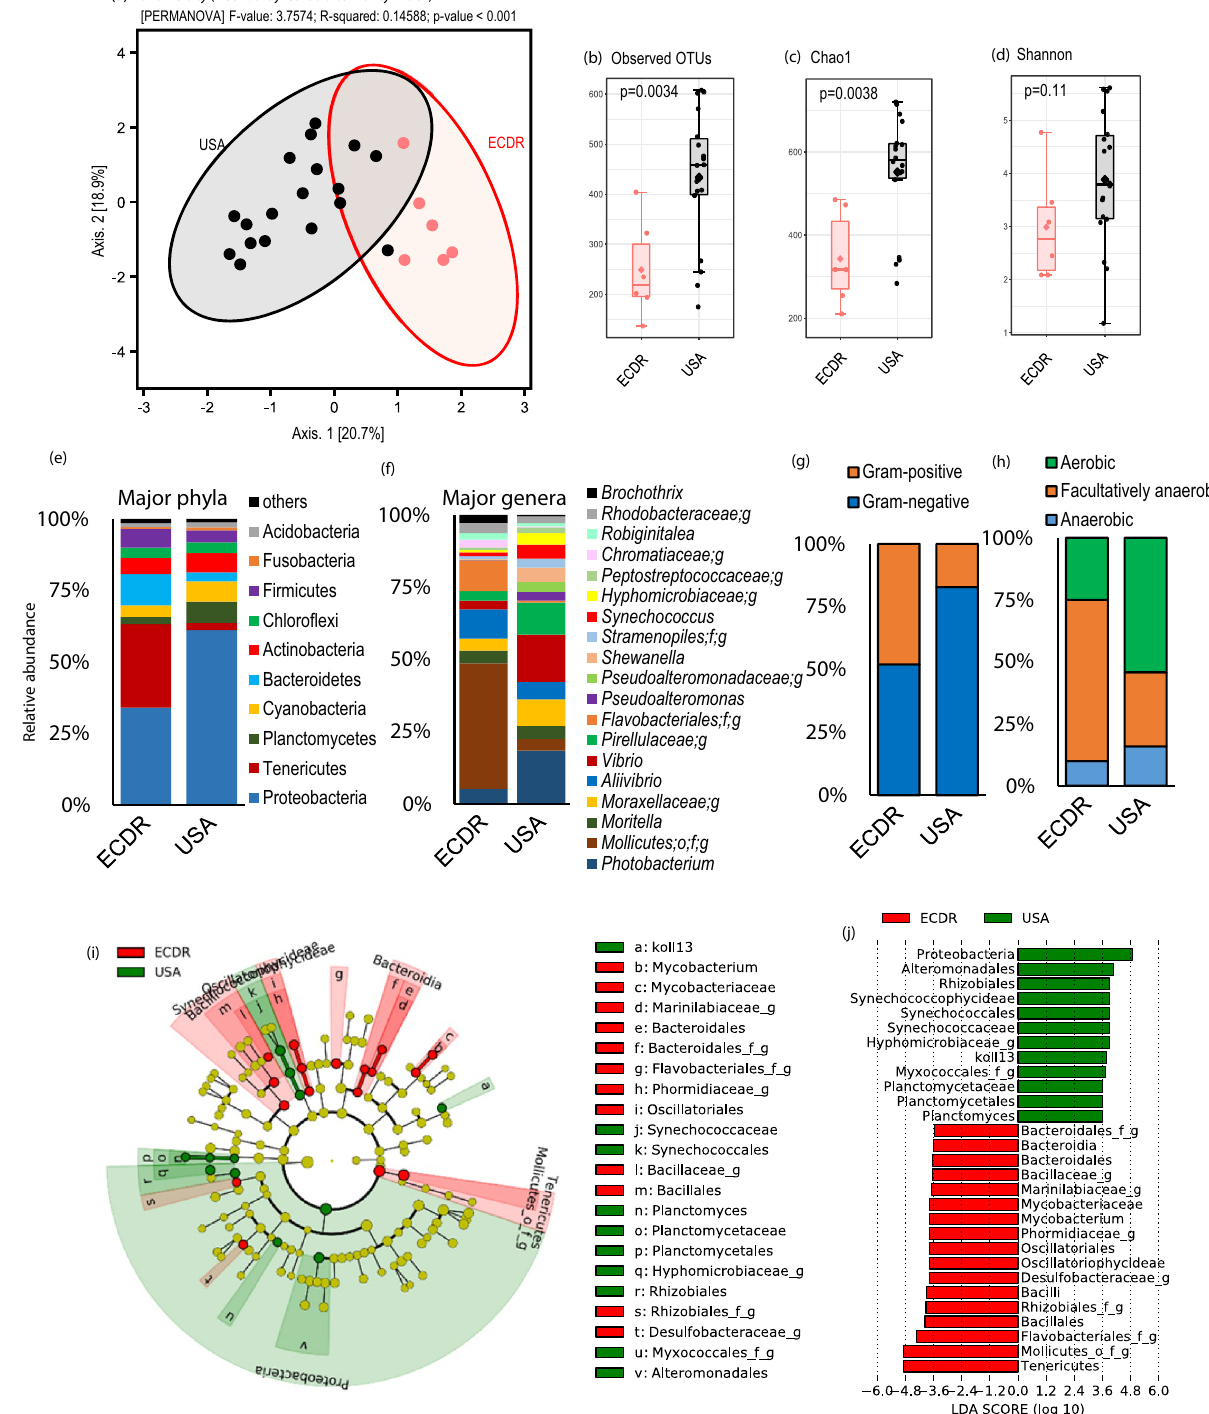
Figure 2. Distinct bacterial microbiome signatures in shrimp from U.S. (wild-caught) versus Ecuador (farm- raised) shrimps. ( a ) Beta-diversity (principal coordinate analysis; Bray–Curtis dissimilarity index; ( b–d ) alpha- diversity indices; ( e , f ) microbiome composition at phylum and genus level; ( g , h ) ratio of gram-positive to gram- negative bacteria and aerobic to anaerobic bacteria; and ( i , j ) linear discriminatory analysis effect size (LEfSe) cladogram representing the significantly unique bacterial taxa driving the difference between the wild-caught (U.S.) versus farm-raised (Ecuador)